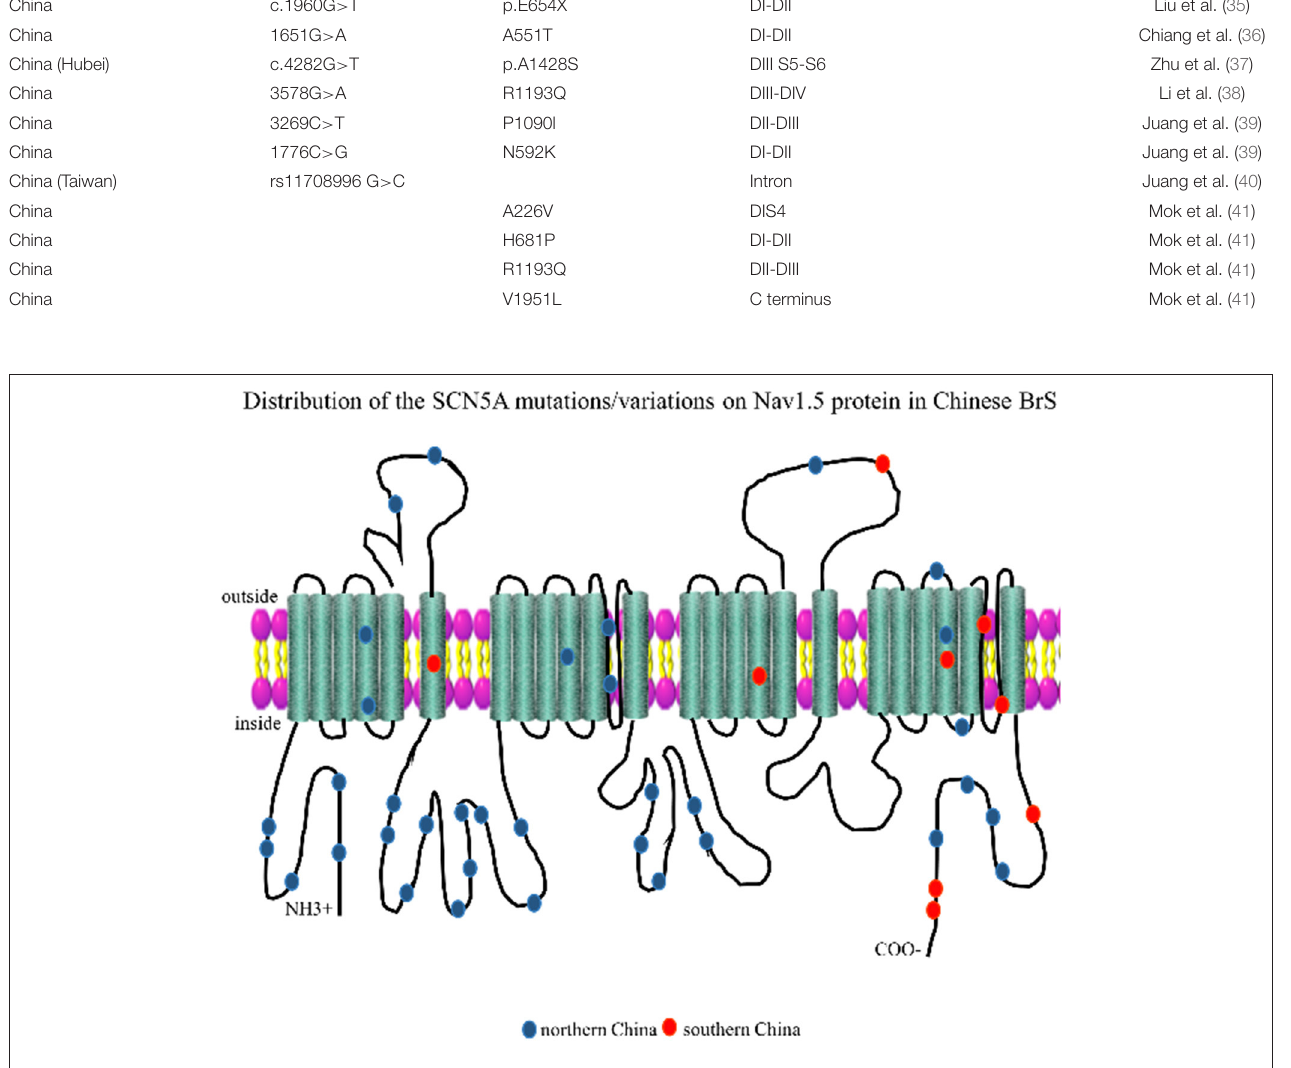
Taiwan) were included. Further analysis of these loci was performed as detailed